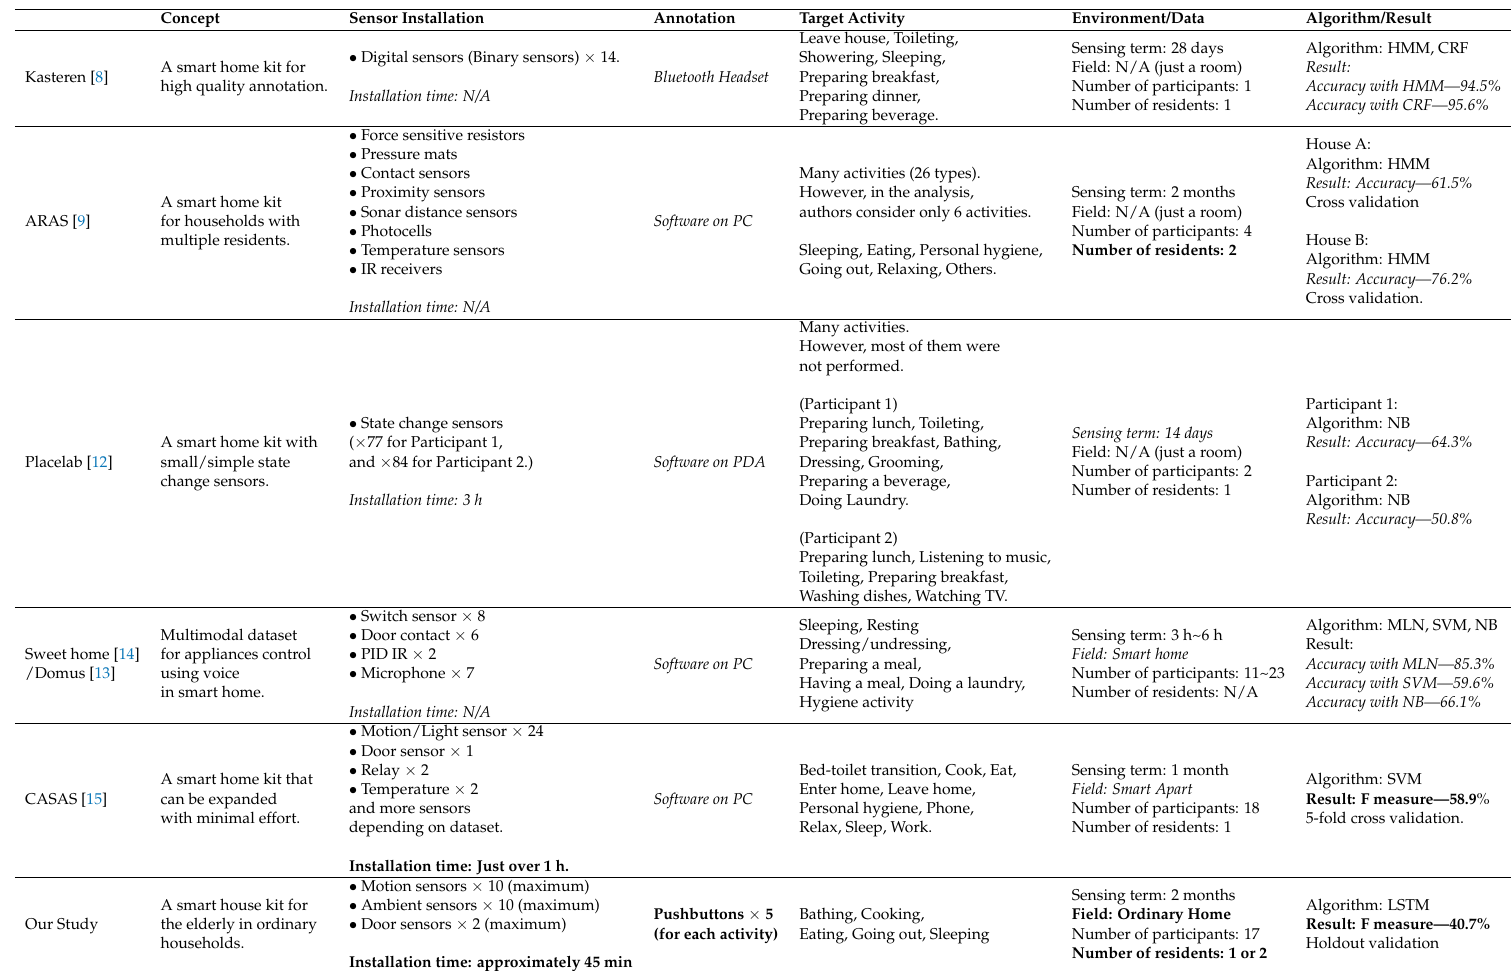
Table 5. Overall comparison with related